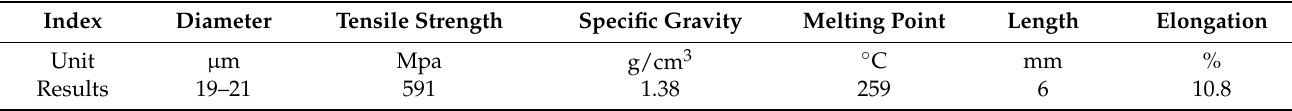
Table 5. Physical characteristics of polyester